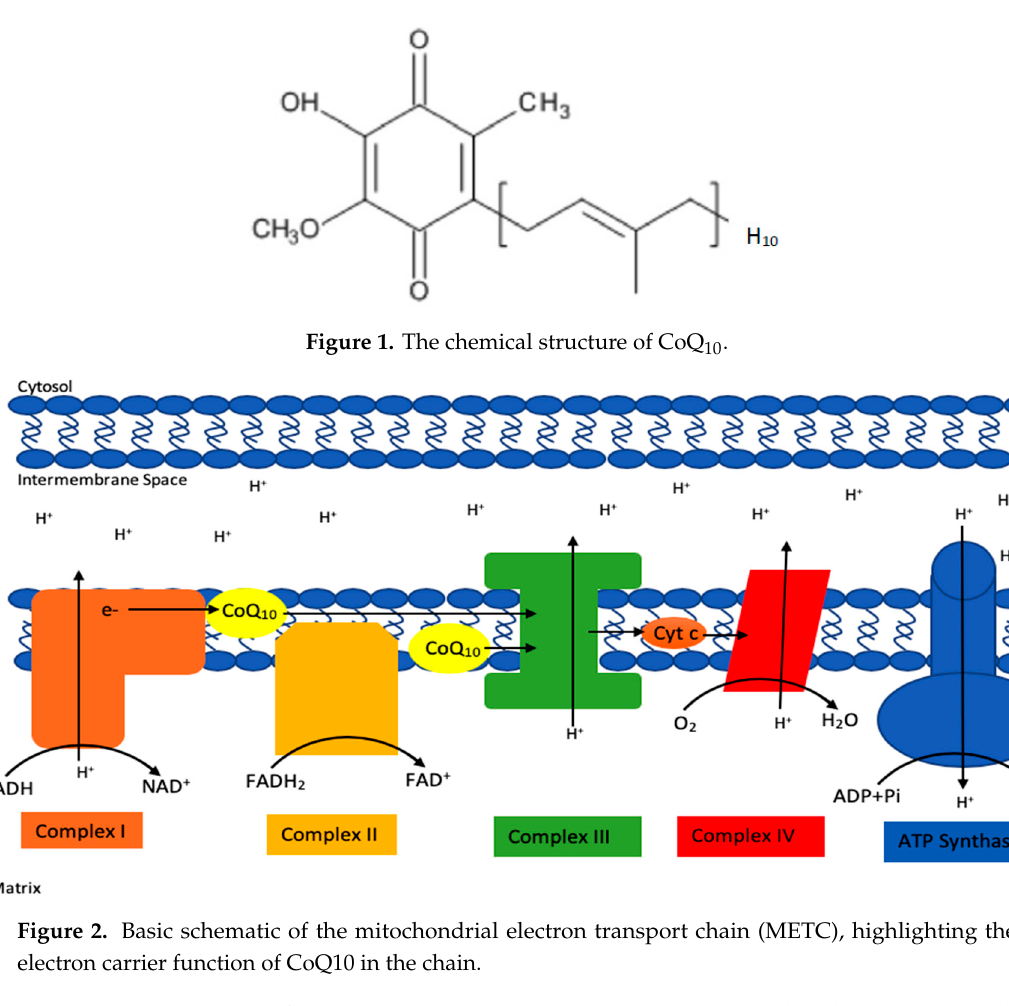
Figure 1. The chemical structure of CoQ 10 .